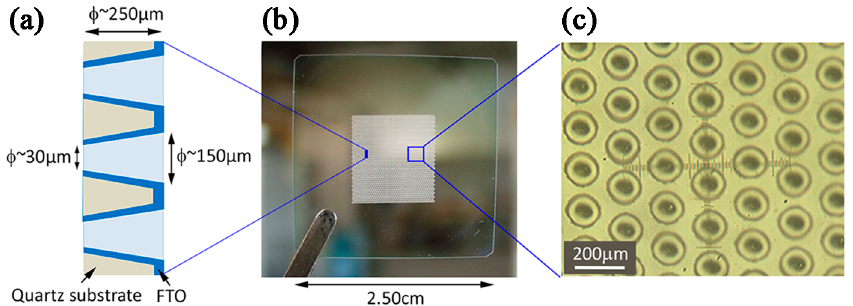
Figure 7. The FTO ‐ laser ‐ drilled electrode: ( a ) scheme of the cross ‐ section; ( b ) photograph and ( c ) optical microscopy image (view from FTO side). Reprinted with permission from [94]. Copyright Elsevier, 2014.